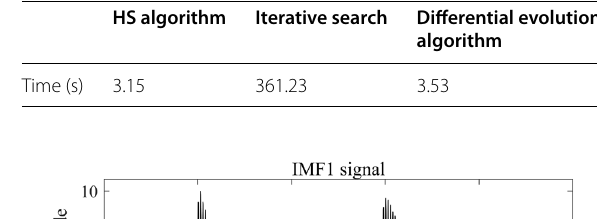
Table 2 Parameter search time of different algorithms